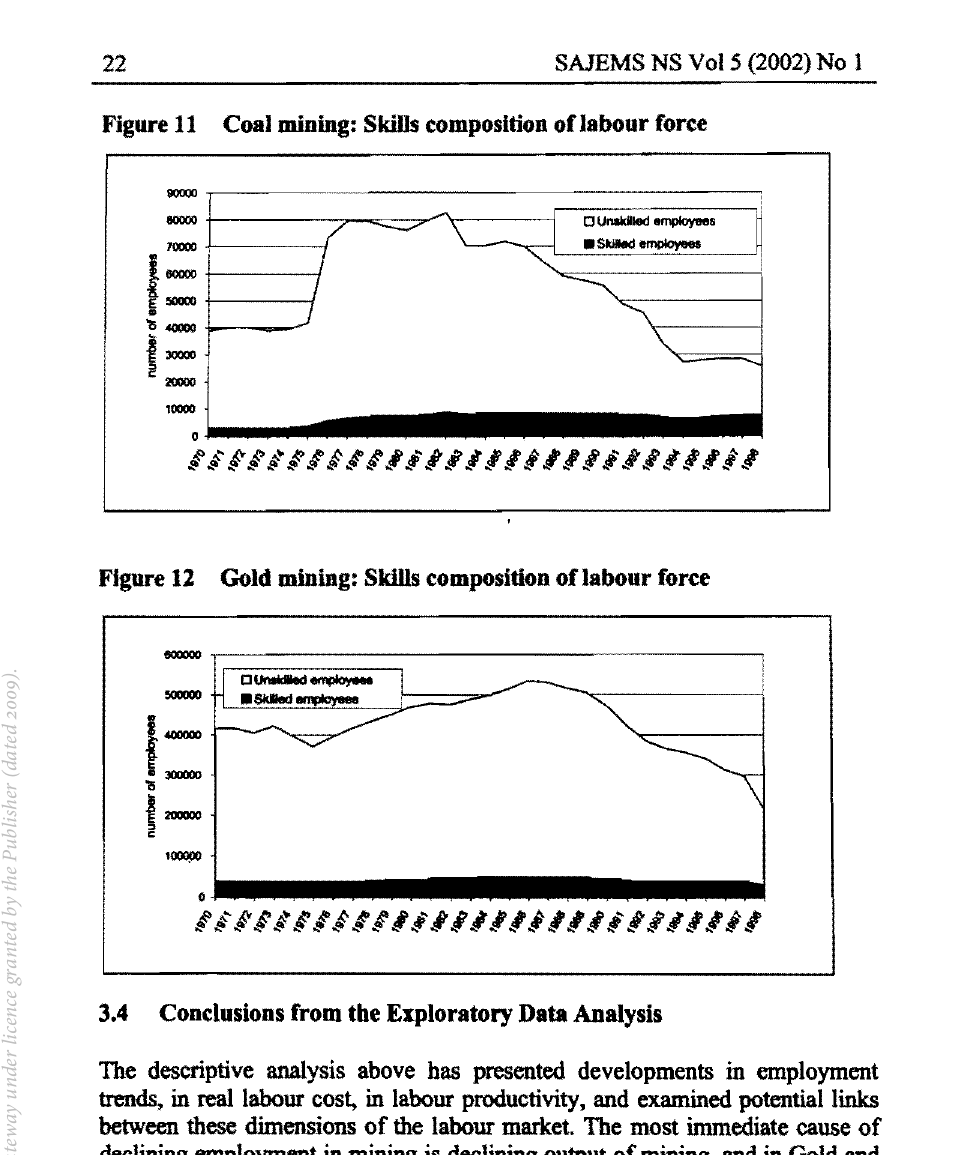
Coal mining: Skills composition of labour force